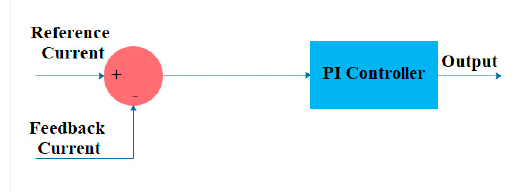
Figure 28. Current control block using PI controller.